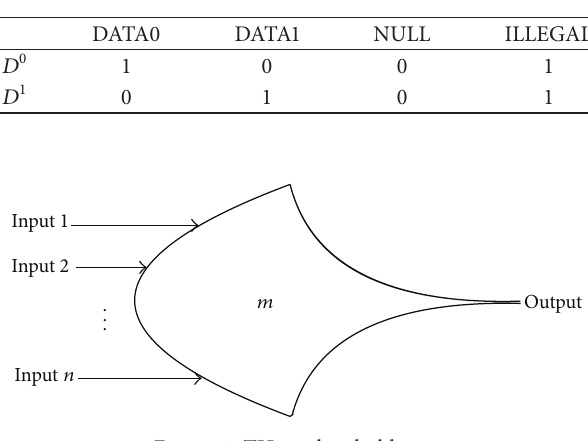
Figure 1: THmn threshold gate.